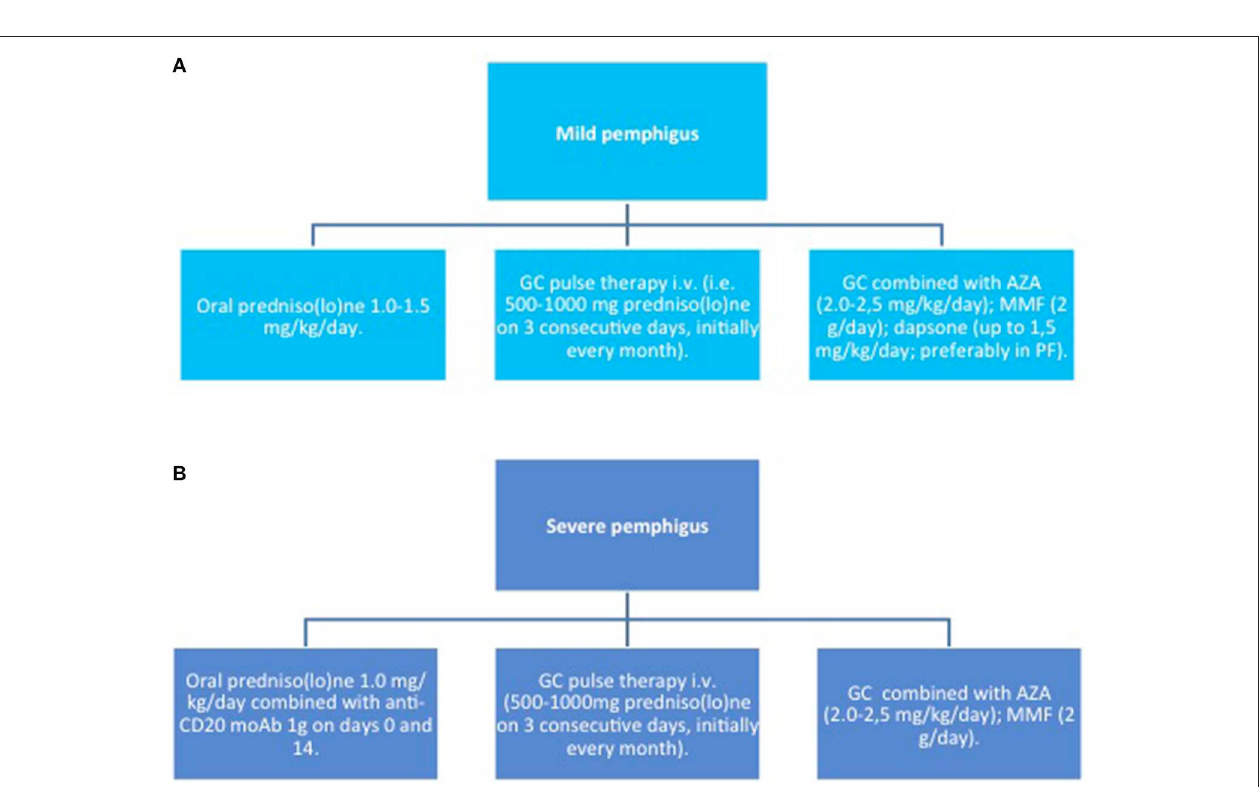
FIGURE 4 | Diagnostic of pemphigus: (A) Intraepidermal acantholysis in pemphigus vulgaris; (B) Subcorneal loss of adhesion in pemphigus foliaceus; (C) Reticular binding of IgG in pemphigus vulgaris.